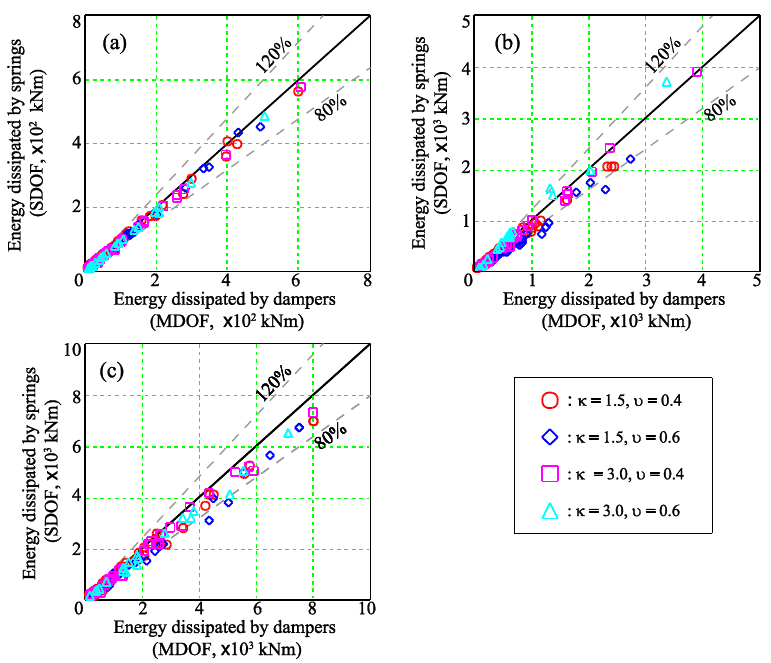
 a Figure 8. Bias ( ) and dispersion ( ) of the simplified method: ( a ) for a three-story frame with dampers; ( b ) for a six-story frame with dampers; and ( c ) for a twelve-story frame with dampers.